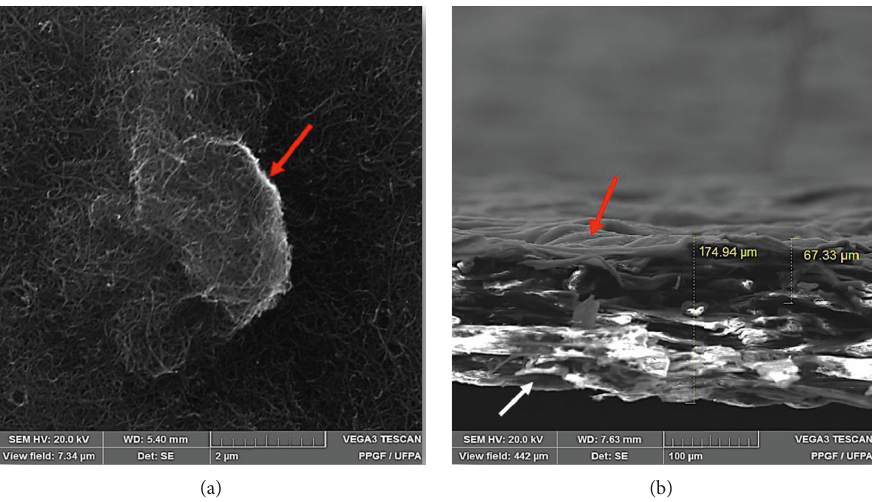
Figure 3: SEM micrographs of the BP electrode, where the top view shows aggregated MWCNTs (a) and cross-sectional view exhibits MWCNTs (red arrow) impregnate into the cellulose of filter paper (white arrow) (b).